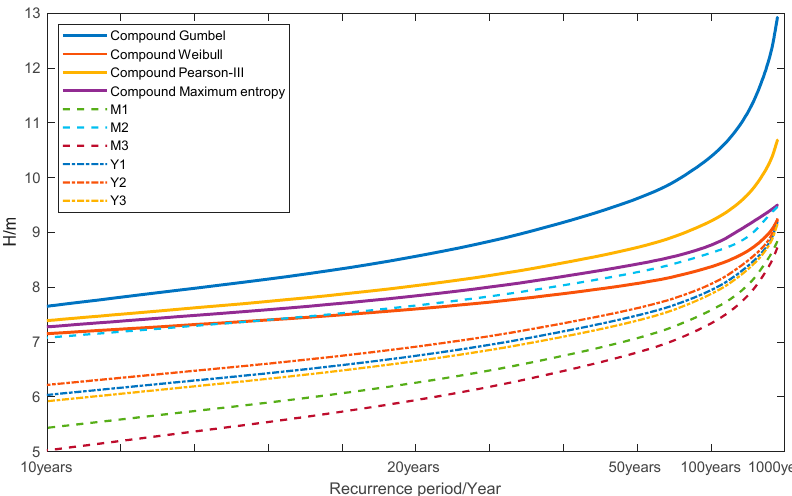
Figure 8. Comparison of the new model and the traditional compound distribution.